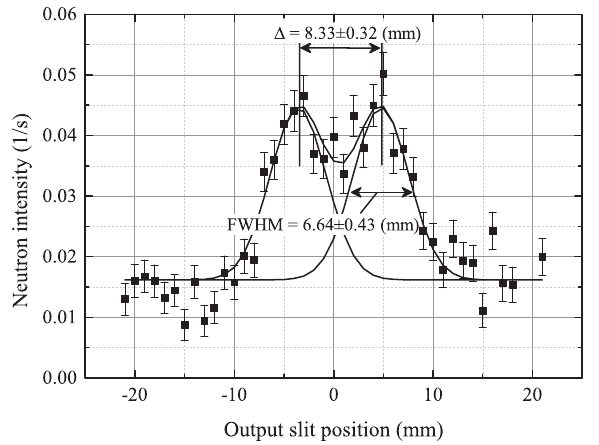
Figure 5. The intensity dependence on the exit slit position. The dimensions of the entrance and exit slits were 4 mm, θ B = 68 ◦ . Beam aperture in the region (2) is equal to